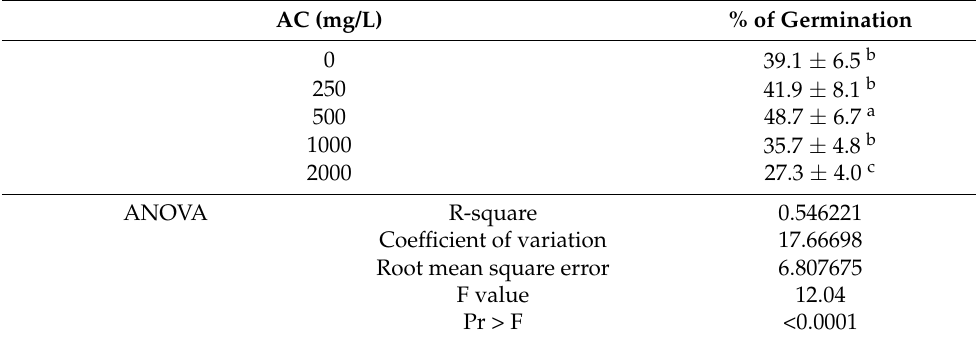
Table 2. Effect of activated charcoal on seed germination.